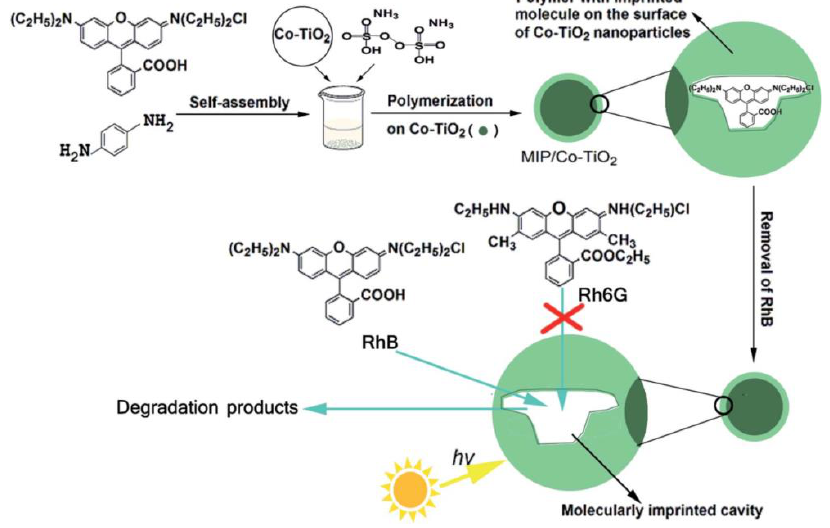
Figure 8. The schematic route for preparation of MIPs/Co–TiO 2 nanocomposites with RhB as the template molecule and its use in photocatalytic degradation. Reprinted with permission from ref [87]. Copyright 2016 American Chemical Society.